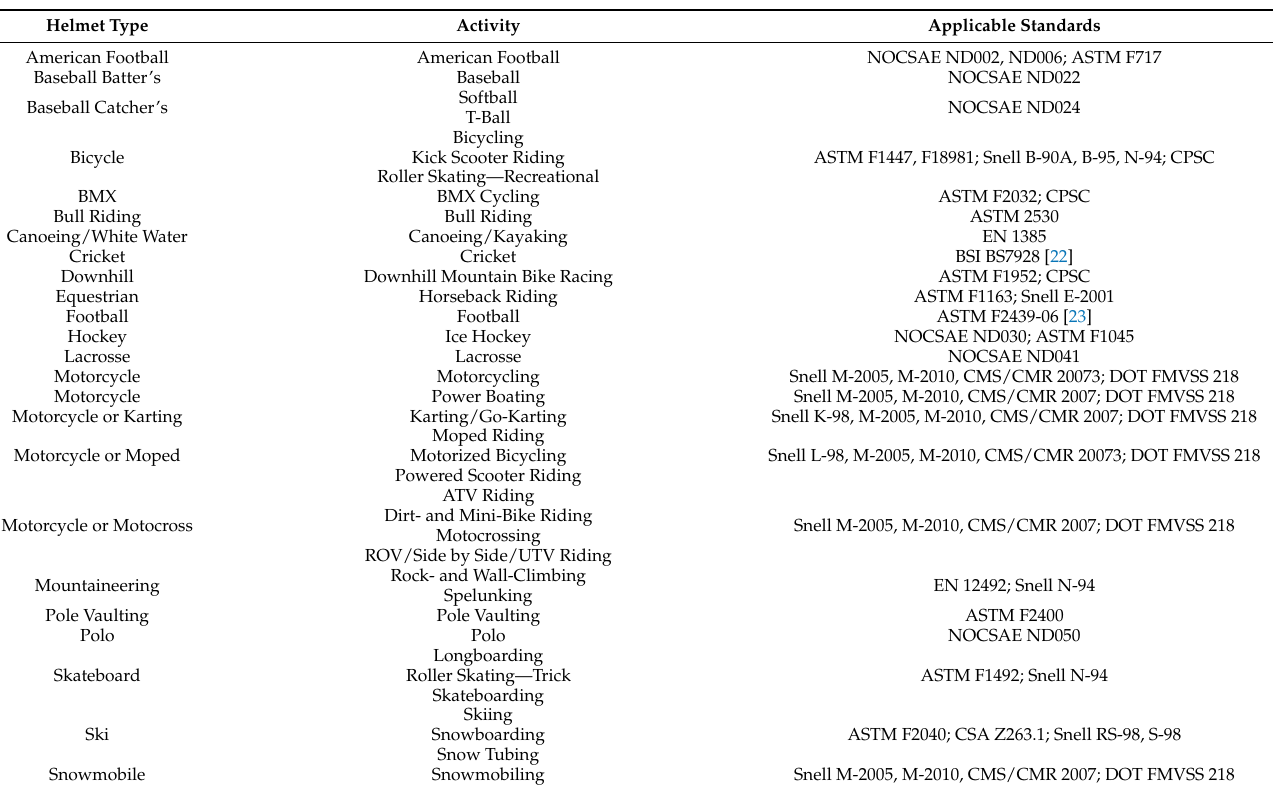
Table 2. Sport helmets categorized by activity